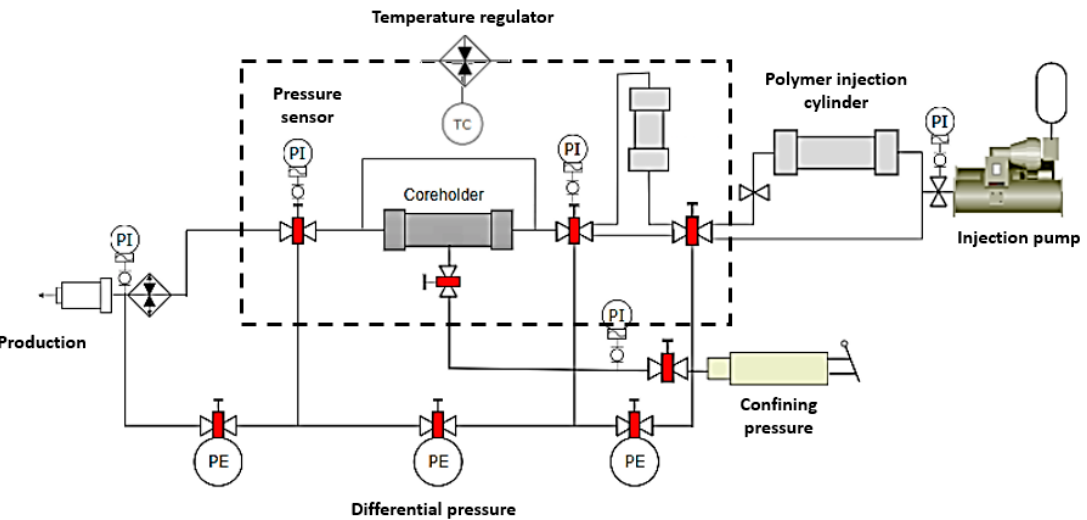
Figure 1. Schematic representation of the coreflooding displacement system for the dynamic evaluation of the polymer solutions in porous media.